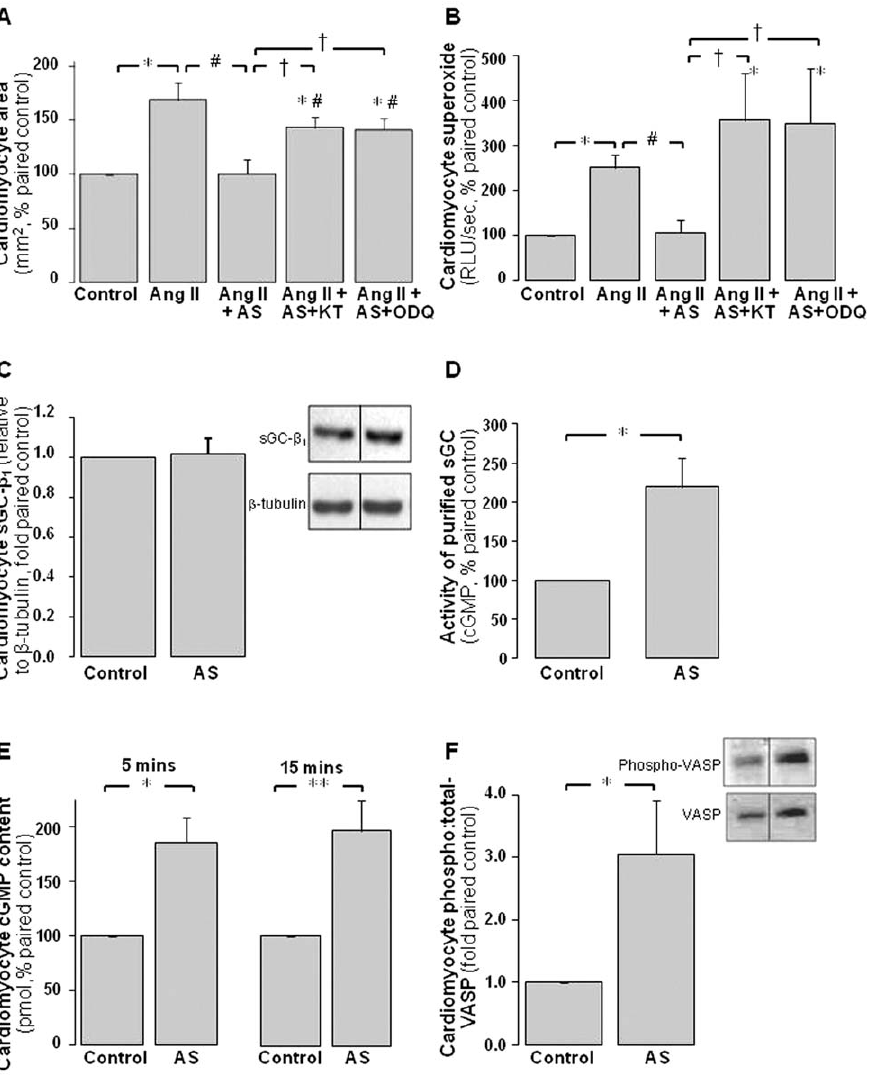
Figure 4. The antihypertrophic actions of Angeli’s salt utilize sGC/cGMP signaling. A The antihypertrophic action of AS (1 m mol/L, added 4 6 /day over 48 h) on cell size is attenuated by the cGK-I inhibitor KT5823 (KT, 250 nmol/L) and by the sGC inhibitor ODQ (1 m mol/L, n=5